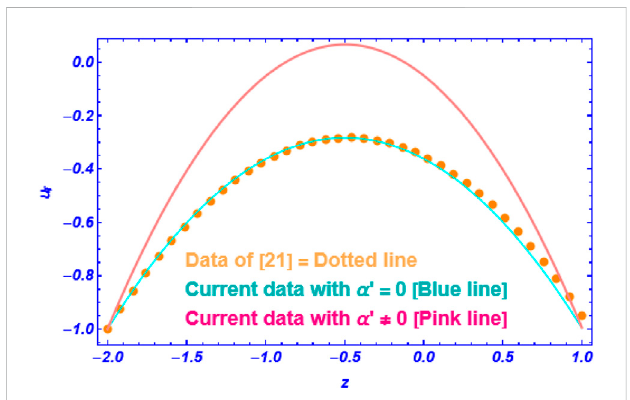
FIGURE 7 Comparison of current results with the existing